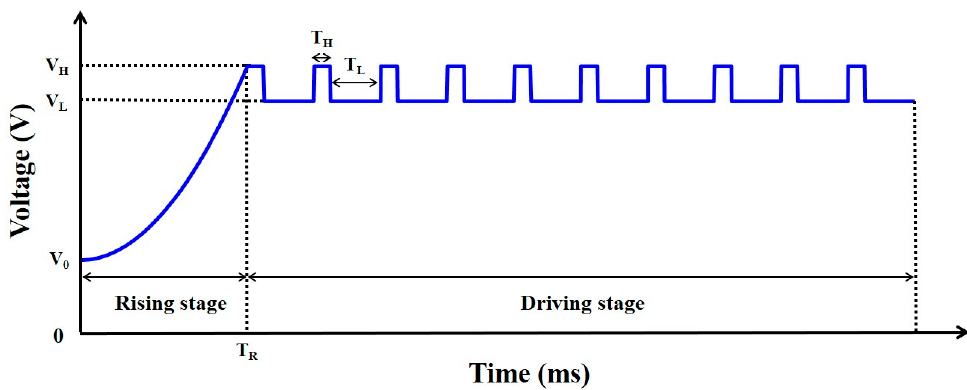
Figure 3. The proposed driving waveform for reducing oil film splitting. It is composed of a rising stage and a driving stage. The rising stage is a quadratic function waveform with an initial voltage; the driving stage is a square wave. V 0 is the initial voltage of the rising stage; V L is the low-level voltage of the driving stage. V H is the high-level voltage of the driving stage; T R is the rising time of the rising stage. T H is the driving time of the high level voltage, and T L is the driving time of the low level voltage.